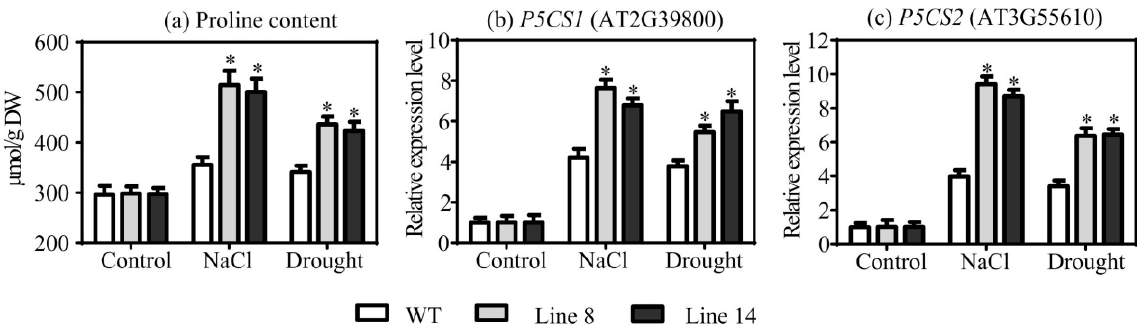
Figure 6. Analysis of proline biosynthesis affected by SaNADP-ME4 . ( a ) Comparison of the proline content of WT and two overexpressing lines under the control, 300 mm NaCl, and drought stress conditions. ( b , c ) Analysis of the relative expression level of pyrroline-5-carboxylate synthase ( P5CS1 ) ( b ) and P5CS2 ( c ) under the control, NaCl, and drought stress conditions. The relative expression in stress conditions was normalized by that in control condition, which was set to 1.0. Values are means ± SD (standard deviation). Asterisks indicate a significant difference at the p < 0.05 significance level, as determined with SPSS v. 19.0.